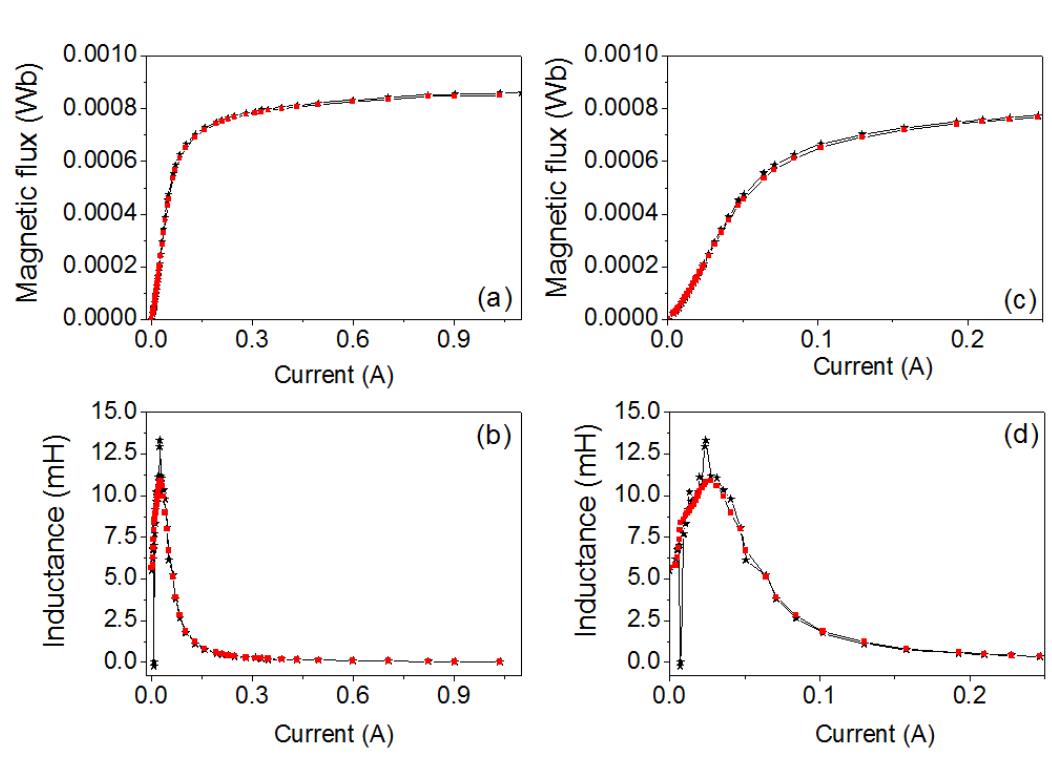
Figure 2. ( a ) Magnetic flux curves; ( b ) L-I curves; ( c ) magnetic flux curves in the range of